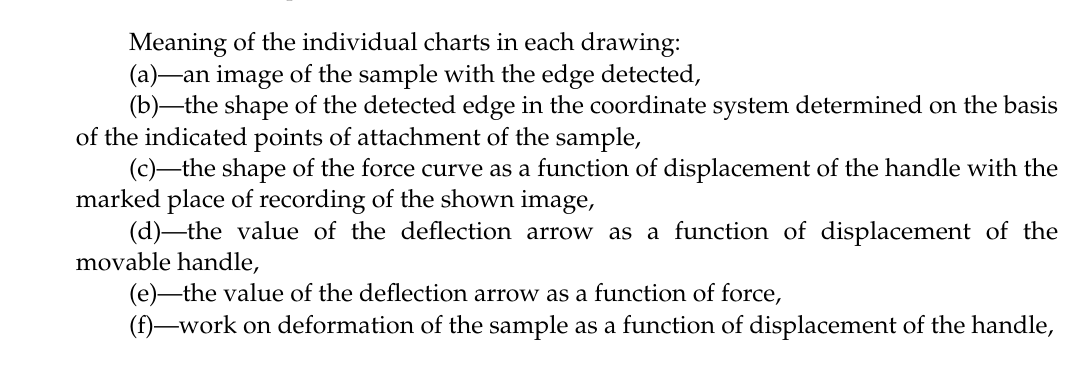
Figure 10. The results of the compression analysis of the paper sample at a clamping length of 4 mm at the maximum compressive force.